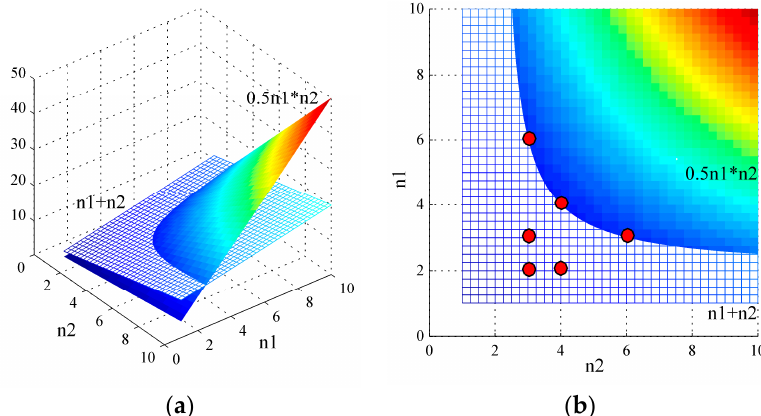
Figure 2. Feasible solutions to the compatibility conditions of the members given by Equations (3) and (4): ( a ) Three-dimensional (3D) view; ( b ) typical solutions marked by the dots.